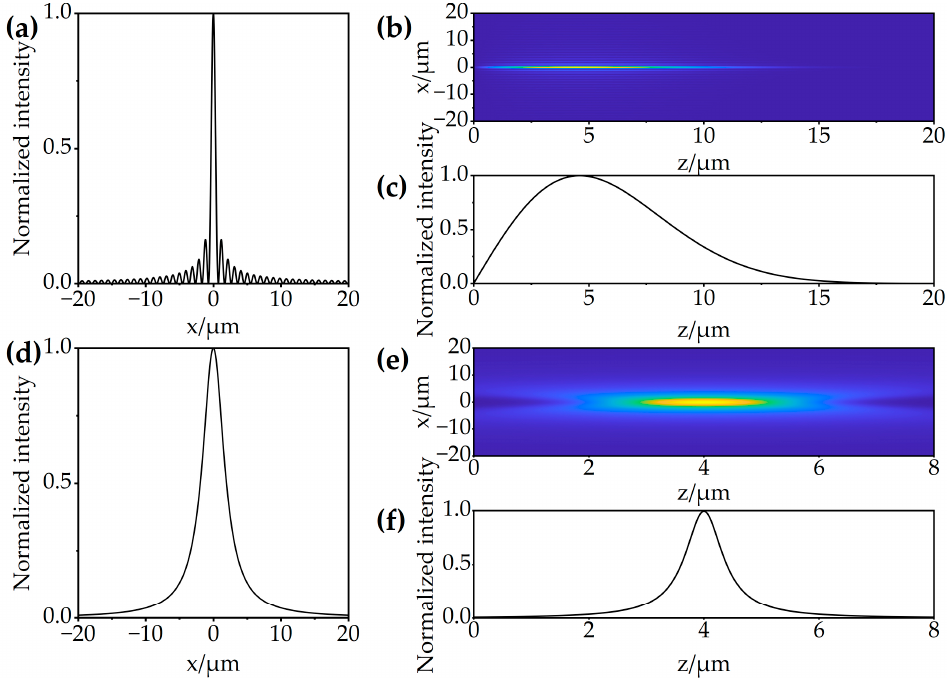
Figure 2. Normalized intensity distribution of the Bessel light field in the ZnSe material. ( a ) Radial light field cross-section at position y = 0. ( b ) Calculated Bessel beam intensity along propagation z. ( c ) The on-axis Bessel beam intensity along propagation z. Normalized intensity distribution of the Gaussian light field in the ZnSe. ( d ) Radial light field cross-section at position y = 0. ( e ) Calculated Gaussian beam intensity along propagation z. ( f ) The on-axis Gaussian beam intensity along propagation z.